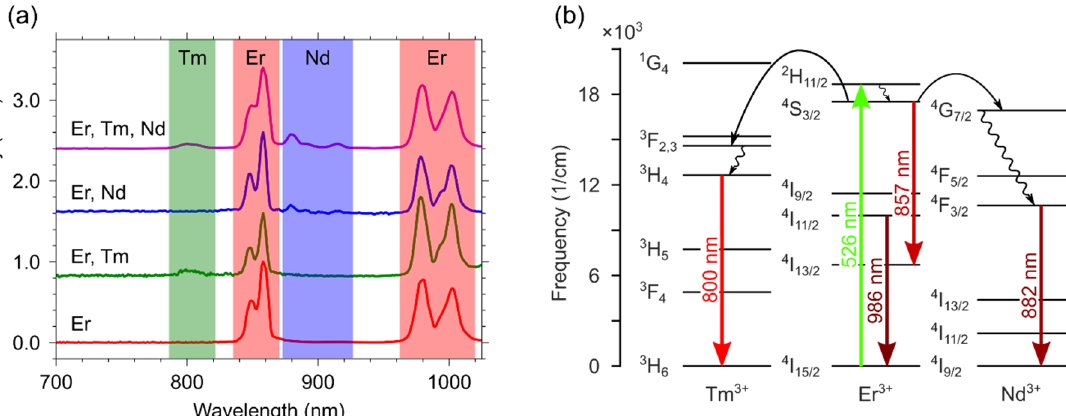
Figure 4. ( a ) Emission spectra and ( b ) scheme of energy migrations between ions for the single-, double-, and triple-doped YVO 4 : Nd 3+ (0.03 at.%), Er 3+ (3 at.%), and Tm 3+ (1 at.%) samples under excitation with λ ex = 526 nm.